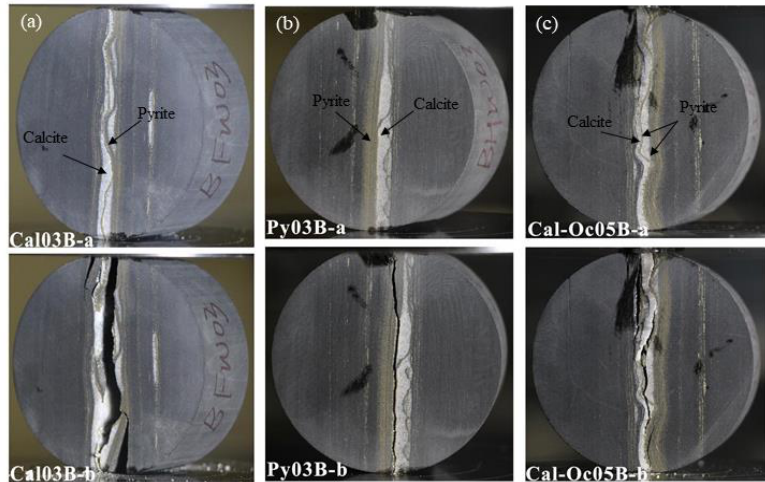
Figure 13. Association development of pyrite lamina and calcite lamina and their broken pictures. ( a ) pyrite lamina embedded in calcite lamina; ( b ) pyrite developed tightly adjacent to calcite lamina; ( c ) pyrite lamina embedded in and adjacent to calcite lamina.